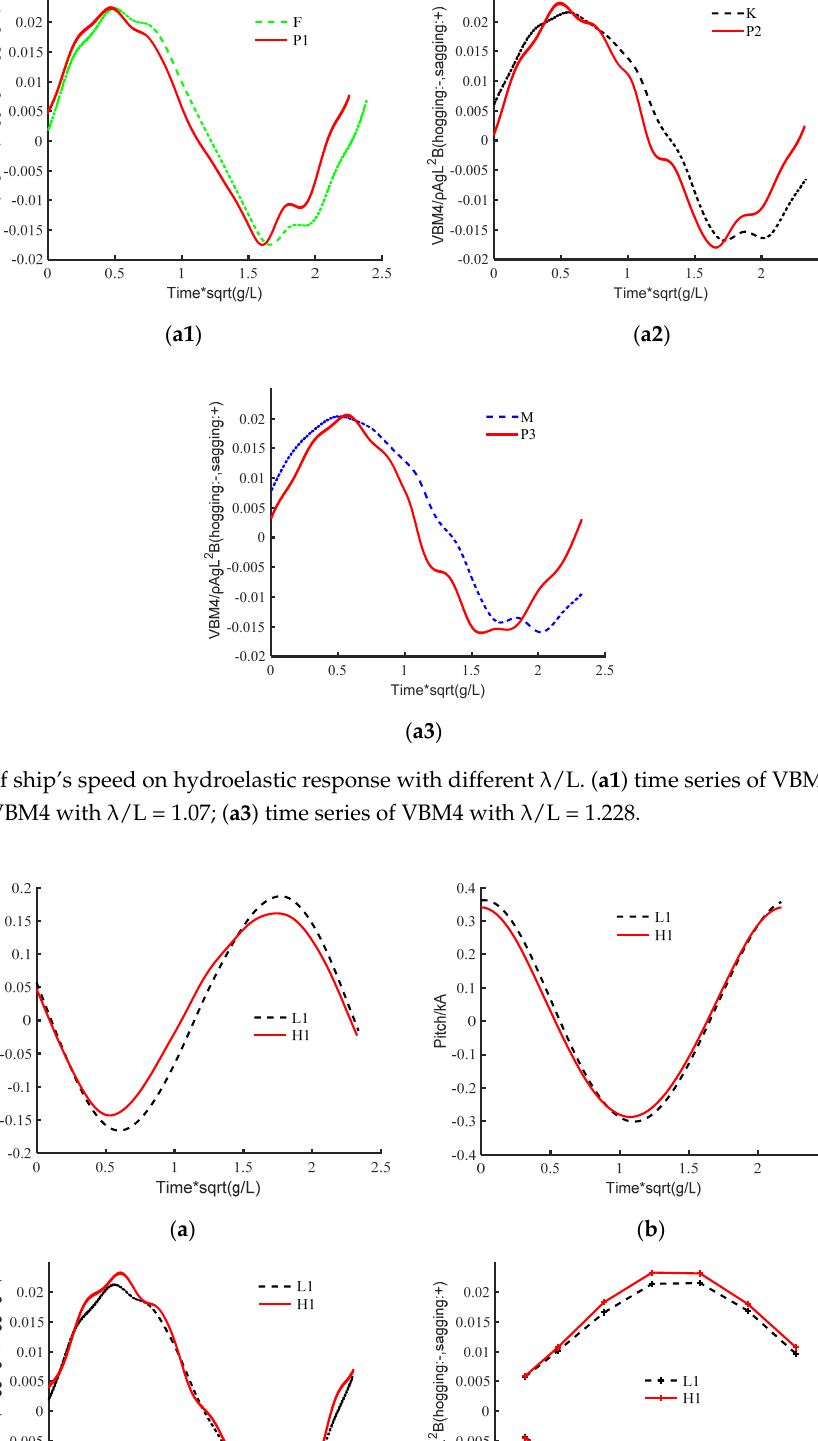
Figure 12. Effects of ship’s speed on rigid body motion response with different λ /L. ( a1 ) time series of pitch with λ /L = 0.857; ( a2 ) time series of pitch with λ /L = 1.07; ( a3 ) time series of pitch with λ /L=1.228;.